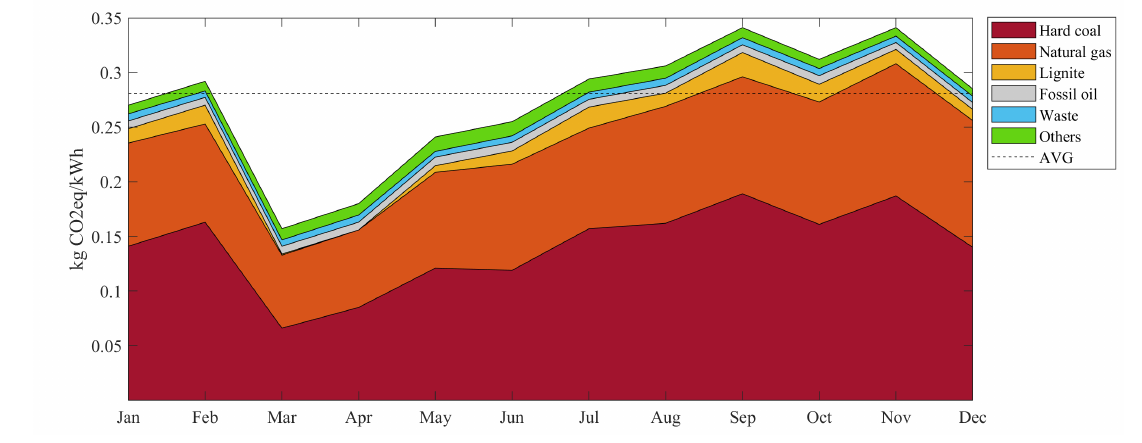
Figure 11. Monthly peak hours GWP compared with average through the year (dotted line) in Spain.